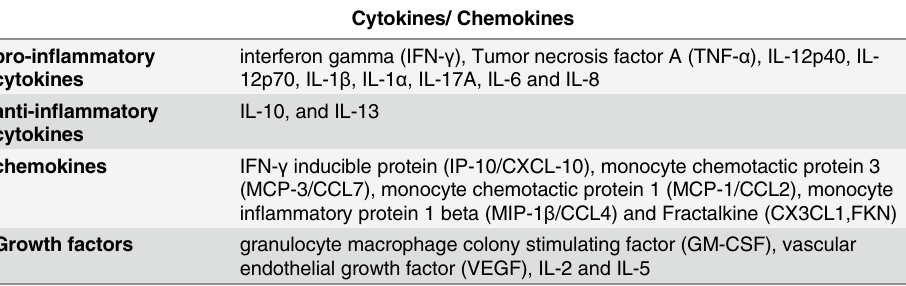
Table 1. Classification of detective cytokines and